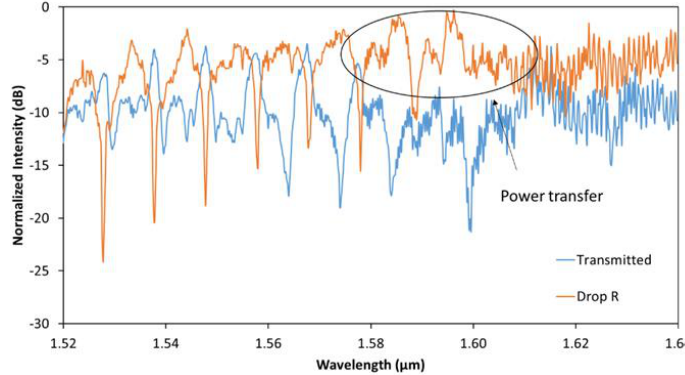
Figure 8. Experimental transmitted and dropped powers for a 20 × 10 μm 2 rectangle with a 160-nm gap for the TM mode.